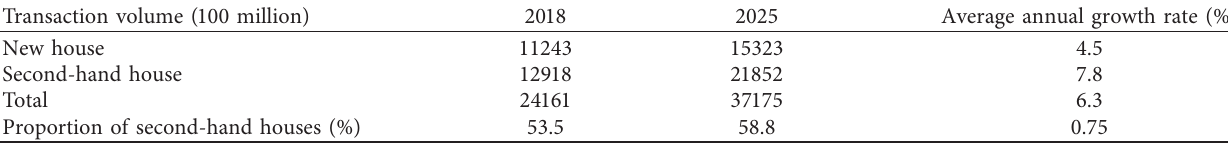
Table 1: The predicted housing transaction scale in the Guangdong-Hong Kong-Macao Greater Bay Area in